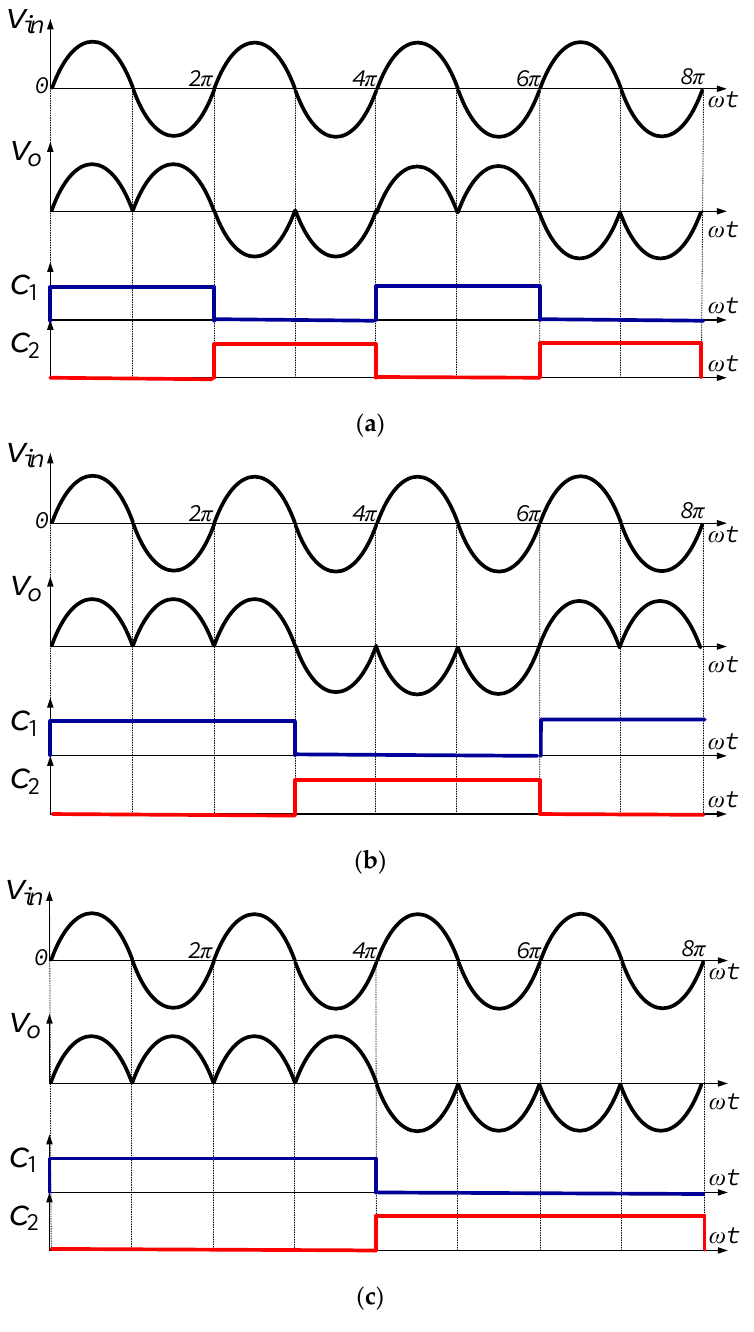
Figure 9. Output step down frequency control with respect to input frequency: ( a ) one-half; ( b ) one-third; ( c ) one-fourth.